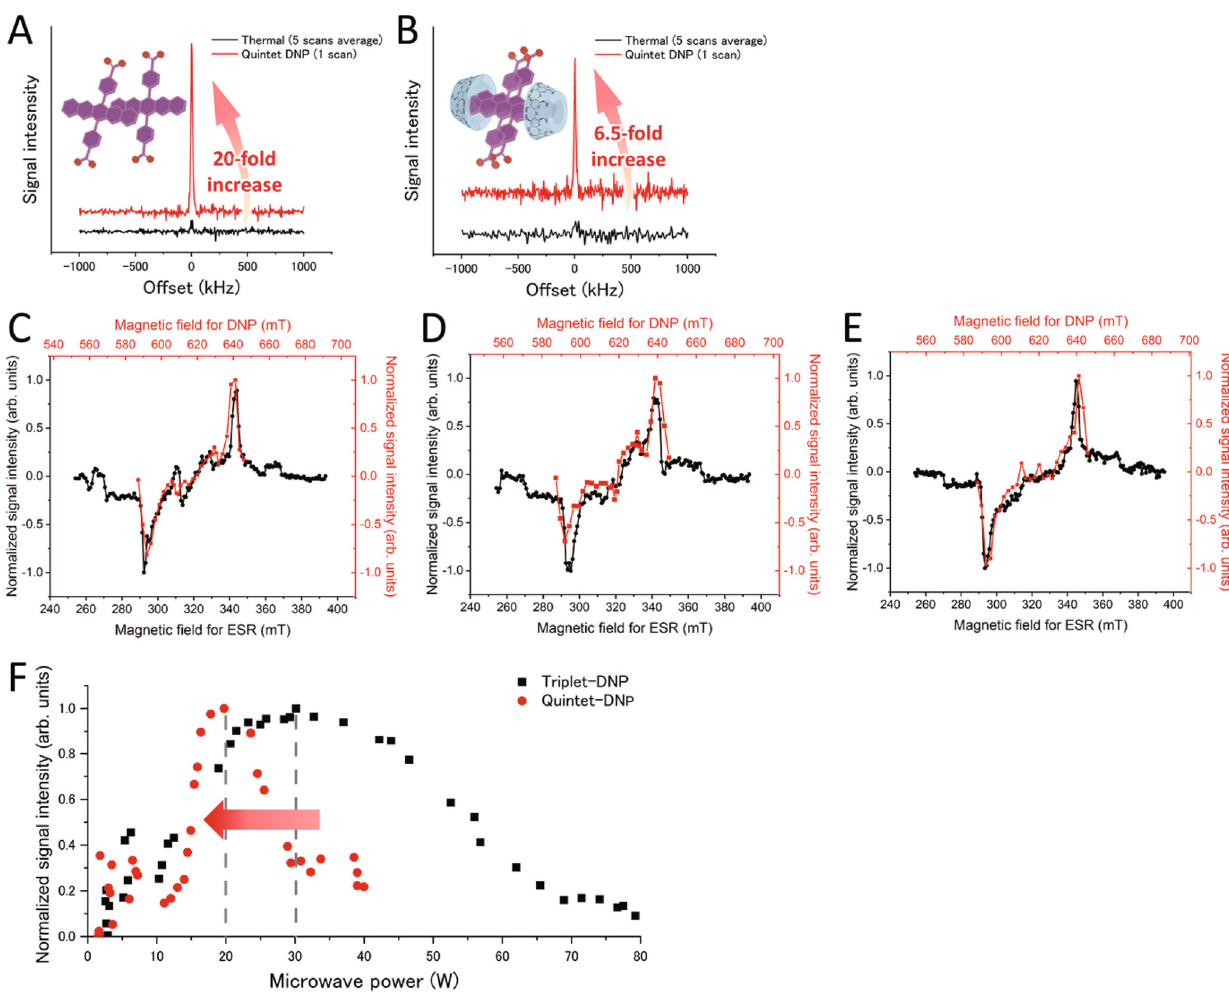
Fig. 5 | DNP using SF-born quintet electron spin polarization. A , B 1 H-NMR sig- nals under thermal conditions (black lines, 5 scans every10min) and after quintet- DNP (red lines, ISE sequence for 5min, 1 scan) of water-glycerol (glycerol- γ CDat100K([NaPDBA]= d 8 :D 2 O:H 2 O=5:4:1)containing A NaPDBAand B NaPDBA- 1mM,[ γ CD]=5mM).Thephoto-excitationwavelengthandfrequencywere527nm and500Hz,respectively.DNPwasperformedbymatchingthemagnetic fi eldtothe quintet peaks. The microwave power and frequency were 20W and 17.30GHz, respectively, the laser powers were 2.7W for A and 1.5W for B . The magnetic fi eld sweep width was 10 μ s. Magnetic fi eld dependence of the signal intensity of the 1 H NMR by DNP and time-resolved ESR spectra in water-glycerol containing C NaPDBA, D NaPDBA- γ CD,and E NaPDBA- β CD([NaPDBA]=1mM,[ β CD]=[ γ CD]= 5mM). Water-glycerol glass (glycerol- d 8 :D 2 O:H 2 O=5:4:1) was used for the DNP measurement at 100K. ISE sequence for 20s ( C , E ) and 30s ( D ) and 1